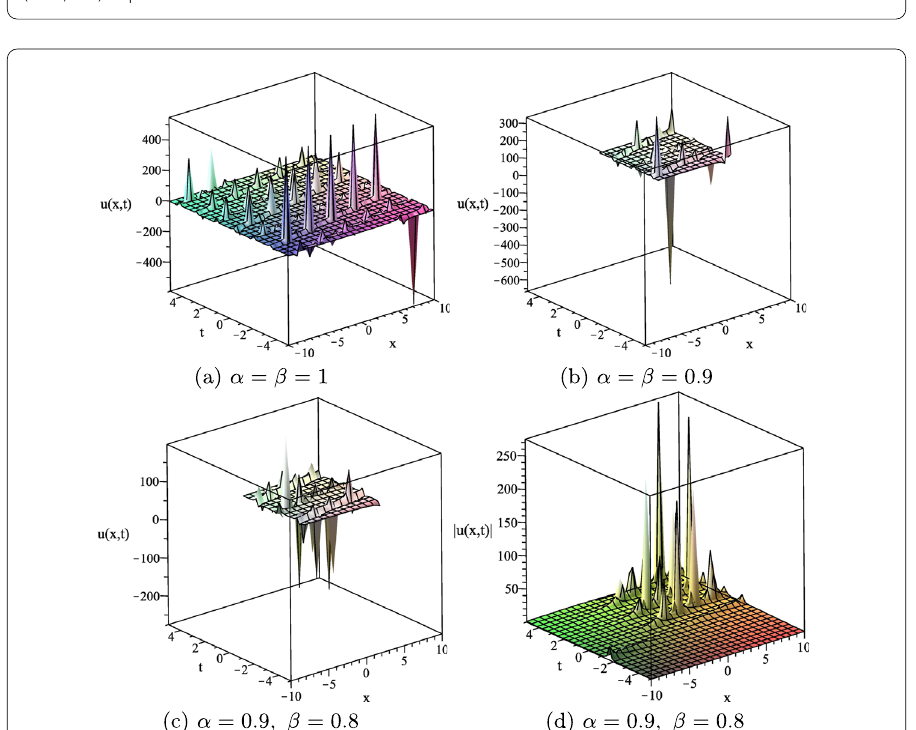
Figure 5 Associated plots of u 2 ( x , t ) in Eq. (62) of Eq. (2) on –10 ≤ x ≤ 10 and –5 ≤ t ≤ 5 using the ( G (cid:2) / G ,1/ G )-expansion